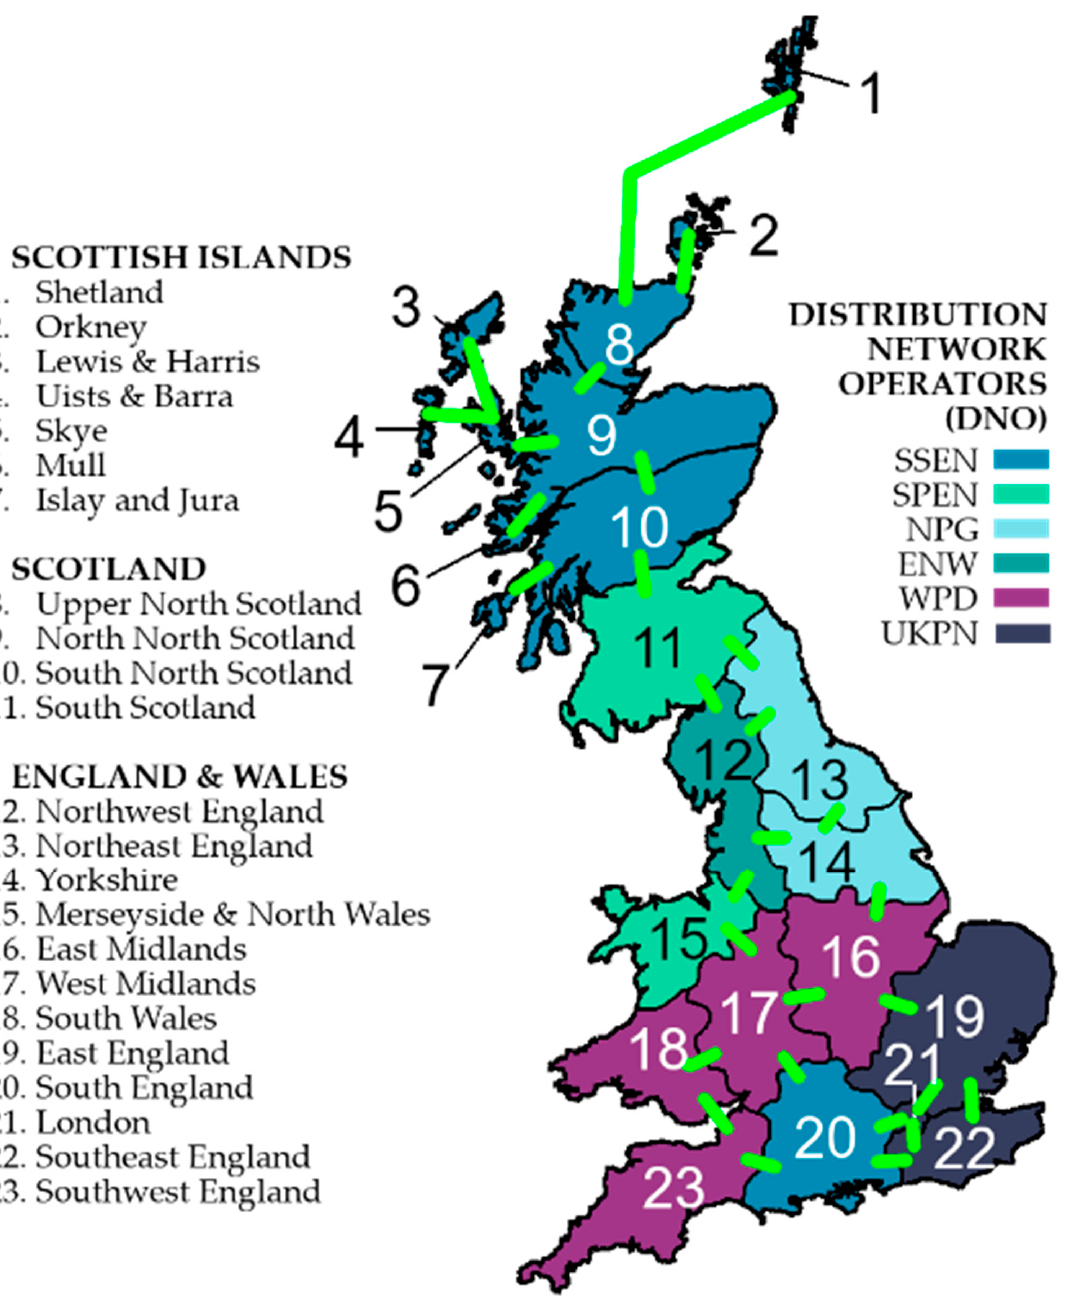
Figure 1. Map of the nodes, colour coded by DNO and with modelled transmission lines between nodes shown in green.